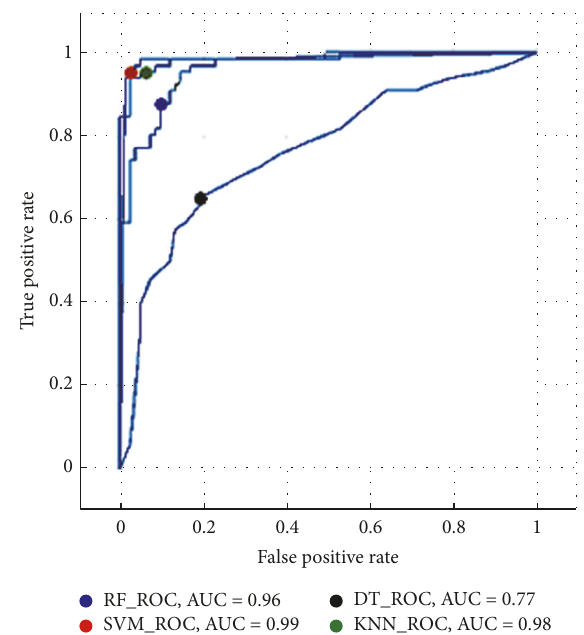
Figure 6: ROC comparison (cooling